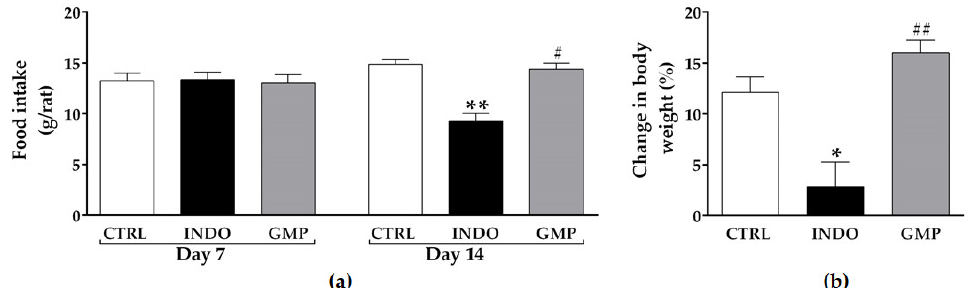
Figure 1. E ff ect of treatment with glycomacropeptide (GMP) on food intake and body weight gain in rats with indomethacin (INDO)-induced enteropathy. ( a ) Daily food intake of rats at day 7 and 14 of the experimental enteropathy protocol. ( b ) Percentage (%) change in body weight of animals at day